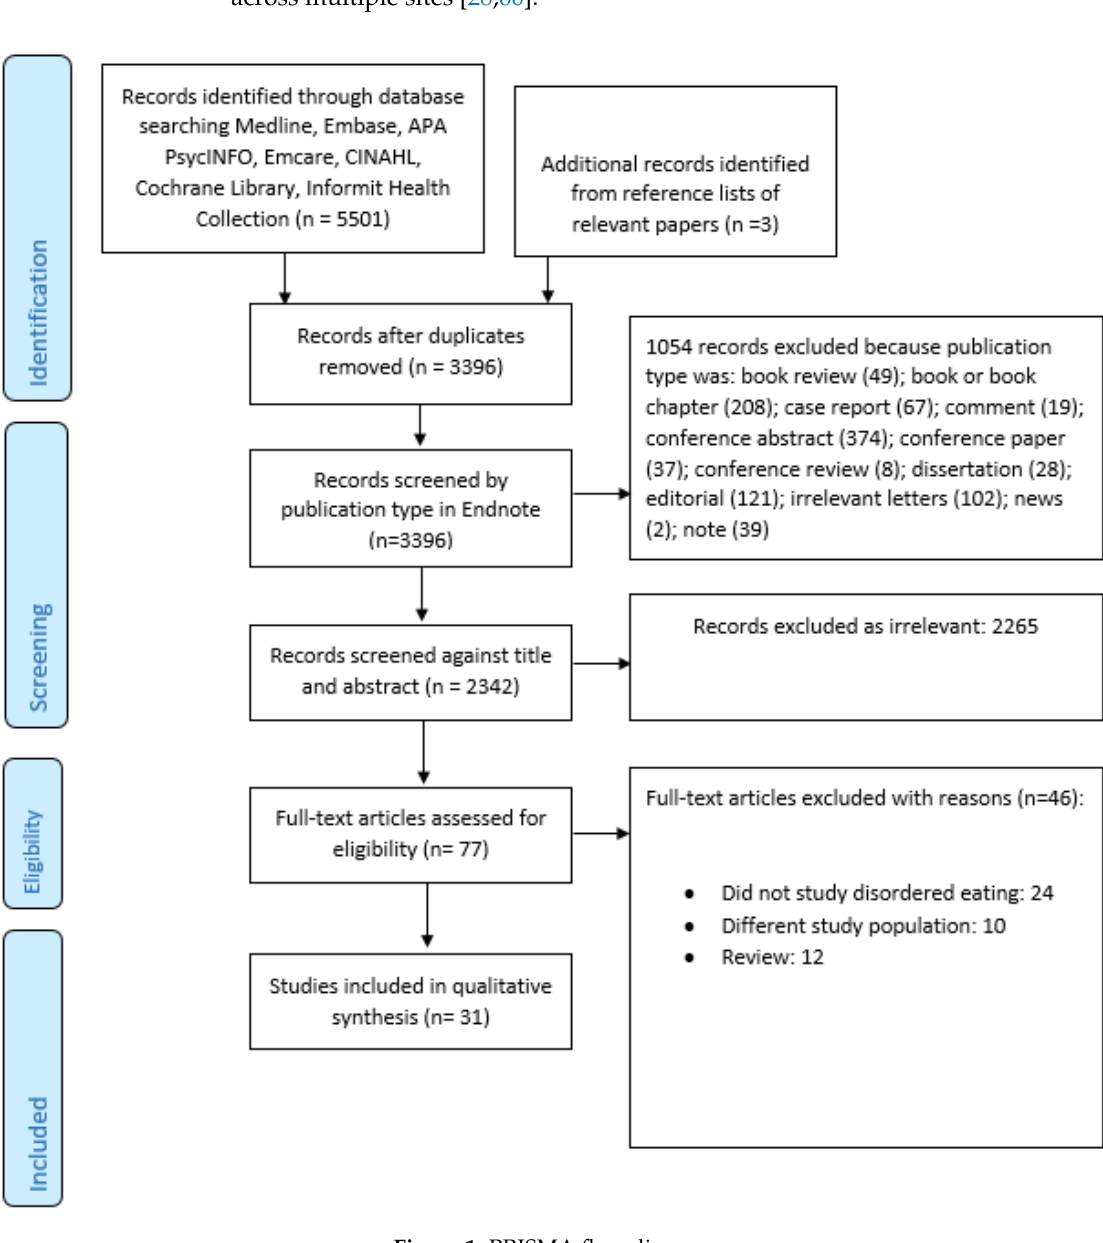
Figure 1. PRISMA flow diagram.